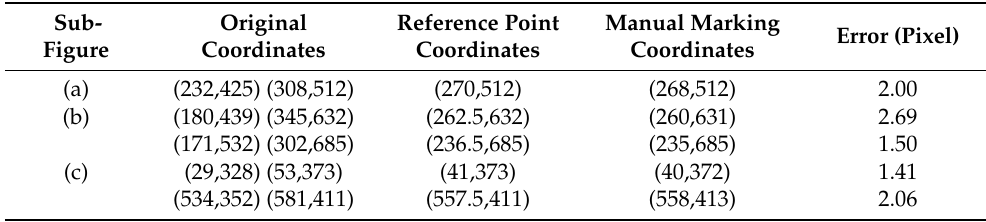
Table 2. Error analysis of the trunk reference point.